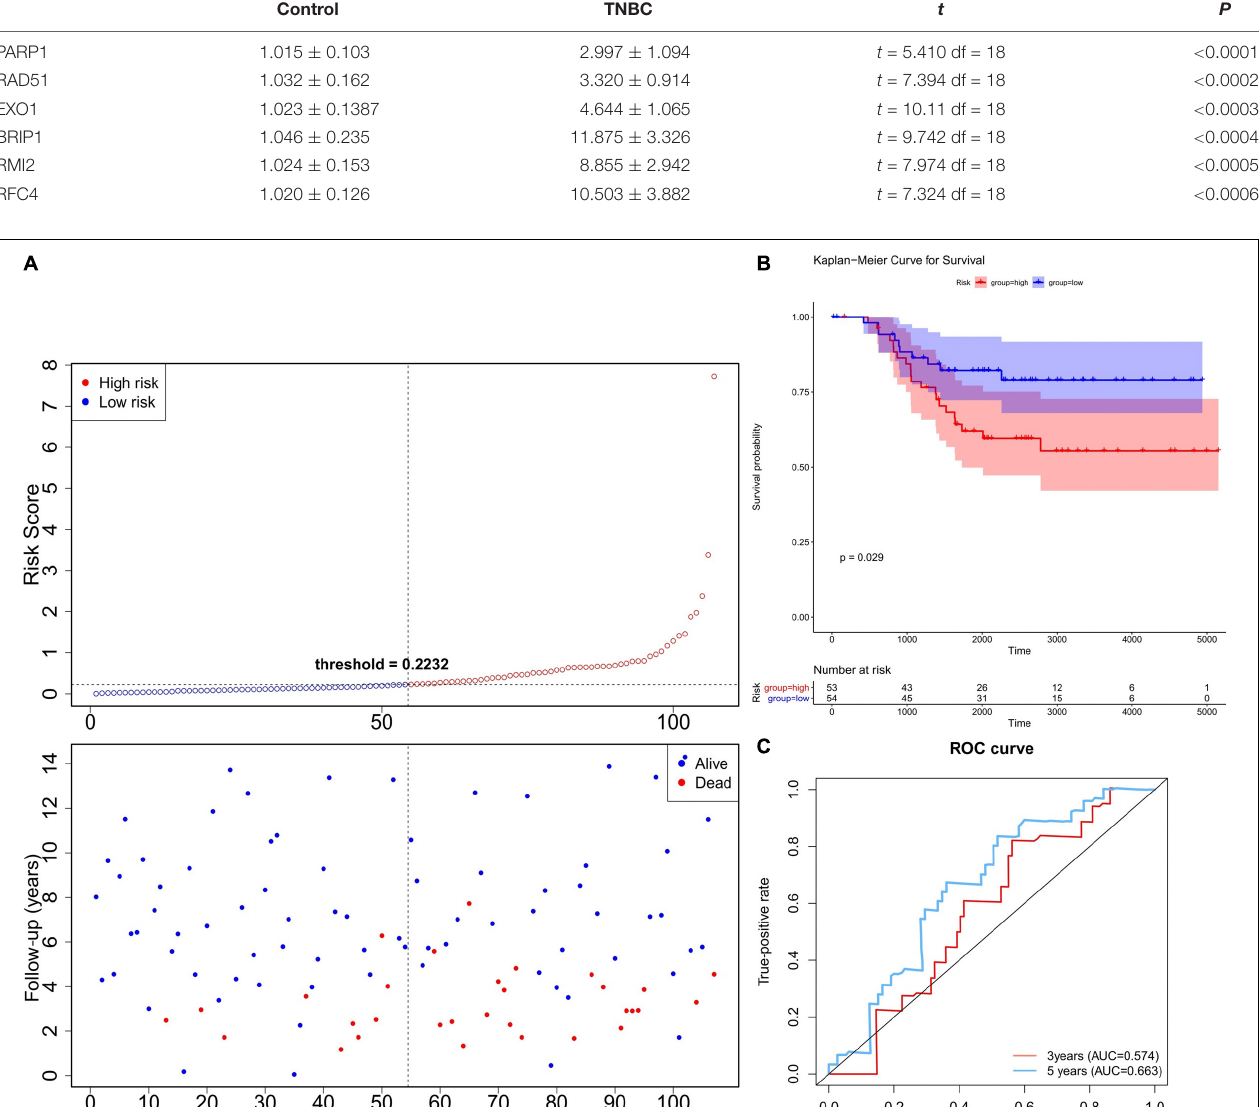
TABLE 1 | Results of quantitative real-time PCR (qRT-PCR).